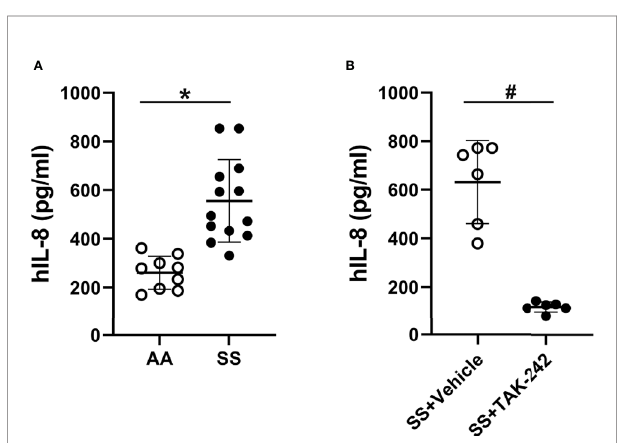
FIGURE 2 | Human SS plasma induces IL-8 secretion in HUVEC through TLR4 signaling. (A) HUVEC were cultured with 2% AA (n=9) or SS (n=13) plasma in RPMI-1640 media for 18 hours. The IL-8 content in the conditioned medium was measured by ELISA. (B) HUVEC were cultured with 2% SS plasma plus vehicle or TLR4 signaling inhibitor, TAK-242 (1 µM) for 18 hours and IL-8 secretion into the media was measured by ELISA (n=6). Bars are means ± SD, * p <0.002, # p